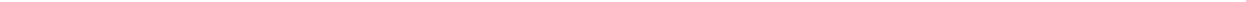
Fig. 4 In fl uence of blood fl ow on positioning of MZB in vivo. a Immuno fl uorescence microscopy of IgM + cells located beyond the CD21-positive boundary of the MZ 1 h after i.v. injection of α LFA-1. Right panel: quanti fi cation of mean fl uorescence intensity (MFI) in a band of 35 µ m of CD21 − IgM + cells outside the CD21 boundary of the MZ. Arrow = IgM + B cells outside the CD21-stained MZ. b Immuno fl uorescence microscopy of CD35 + MZB shuttling into follicles 1 h after i.v. α LFA-1 injection. MZB that shuttled into the follicle were positive for α CD35 (i.v. 15 min) and negative for α CD21 (i.v. 5 min). Right panel: quanti fi cation of MFI inside a band of 70 µ m inside of the marginal sinus. For a , b , symbols in one condition group denote individual follicles, 5 per condition in one experiment, from 3 mice each of control or α LFA-1 injected, 3 experiments total. Arrows = CD35 + CD21 − shuttling MZB inside the follicle. c Blood fl ow in spleen required for normal numbers of shuttling MZB. Confocal immuno fl uorescent images of follicles at 5 min after α CD21 injection ( n = 5 mice), 30 min after injection ( n = 5 mice), or 30 min after injection with the spleen excised at 5 min ( n = 3 mice). MZB were identi fi ed by CD21 staining (white arrows) inside the follicle (MAdCAM-1 used to de fi ne the inner border, shown as a white line). Right panel: quanti fi cation of CD21 + shuttling B cells inside the follicle, 5 follicles per mouse. d Immuno fl uorescence microscopy of CD21 + MZB in the spleen following 24 h of i.v. α LFA-1 injection followed by 5 min of α CD21 i.v. injection. White arrows indicate thinned MZ and increased CD21 staining outside the MZ. Images representative of 4 experiments for control ( n = 12) mice; 2 experiments each for α LFA-1 for 2 h ( n = 7 mice) or 24 h ( n = 7 mice). Data are expressed as the mean ± SEM. ** P <